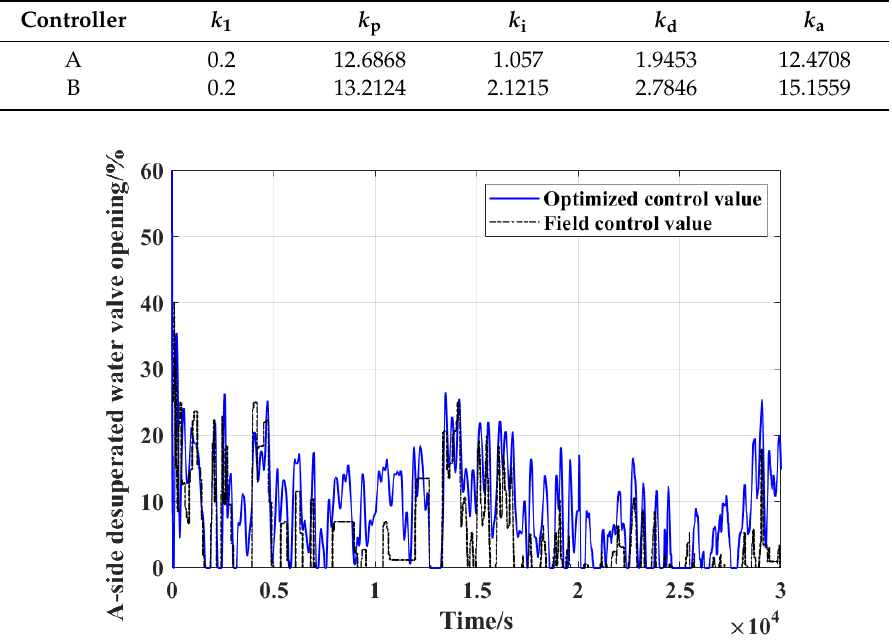
Figure 16. Output of controller A.